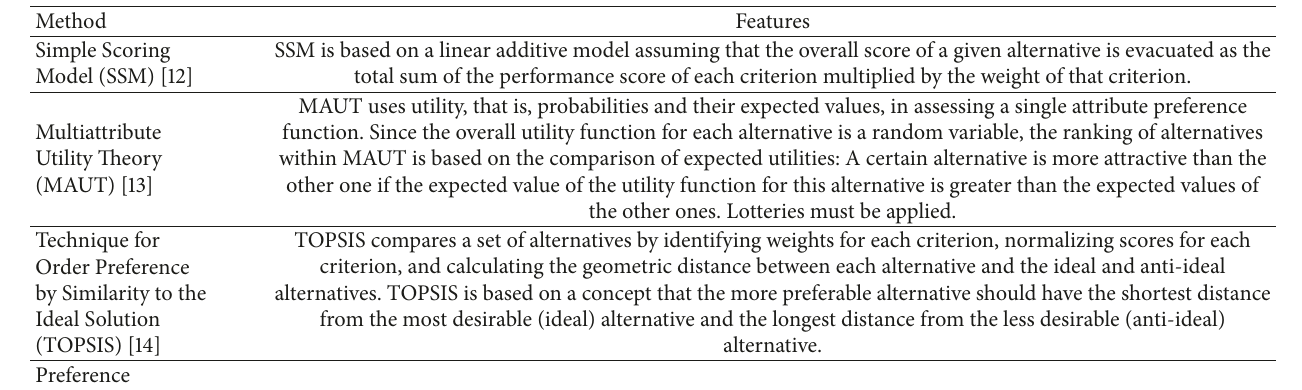
Table 9: Description of different MCDA methods applied to the examination of robustness.